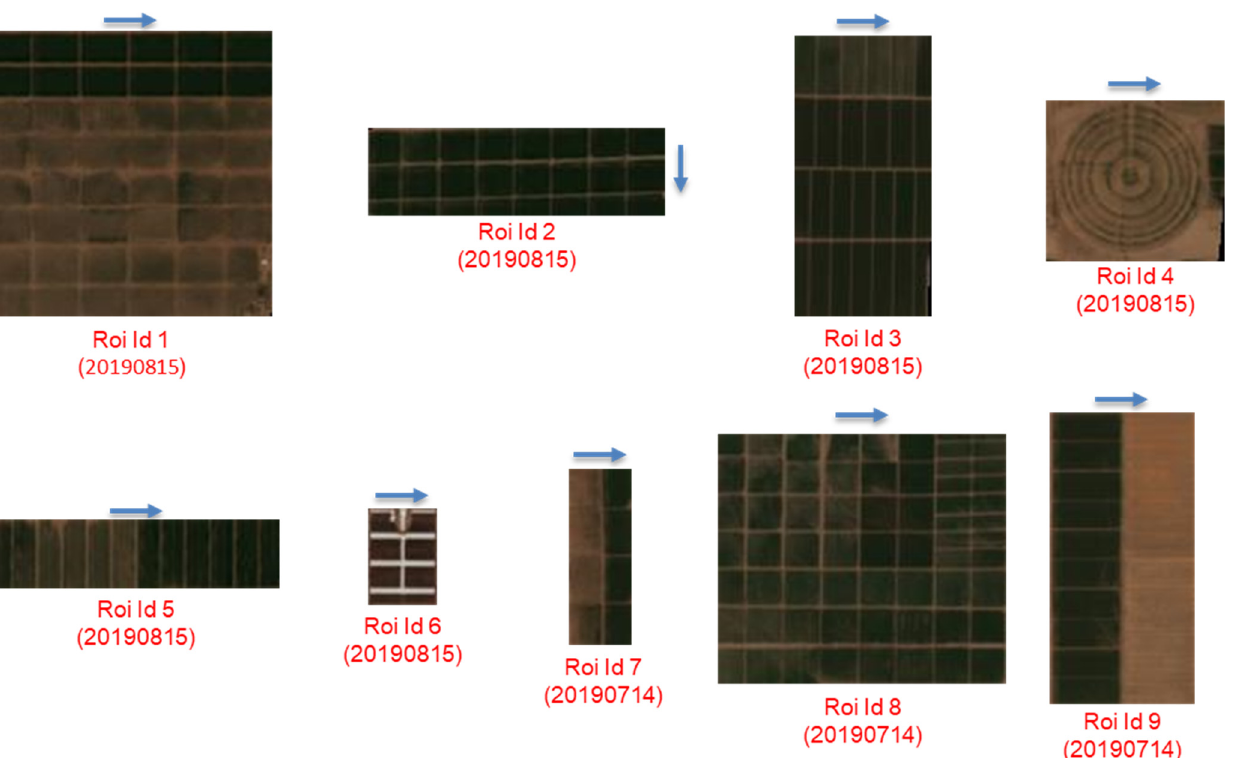
Figure A2. Landsat 10.0 m Red Green Blue color composition Full resolution L2F images (10.0 m) of the Nine ROIs selected over the 12SVB MGRS tile. The ROIs are used for validation of data fusion method. The direction of the edge profile is indicated with blue arrows (mean edge profile computed over records in the orthogonal direction), and the ROI identifier and the observation date are indicated in red.